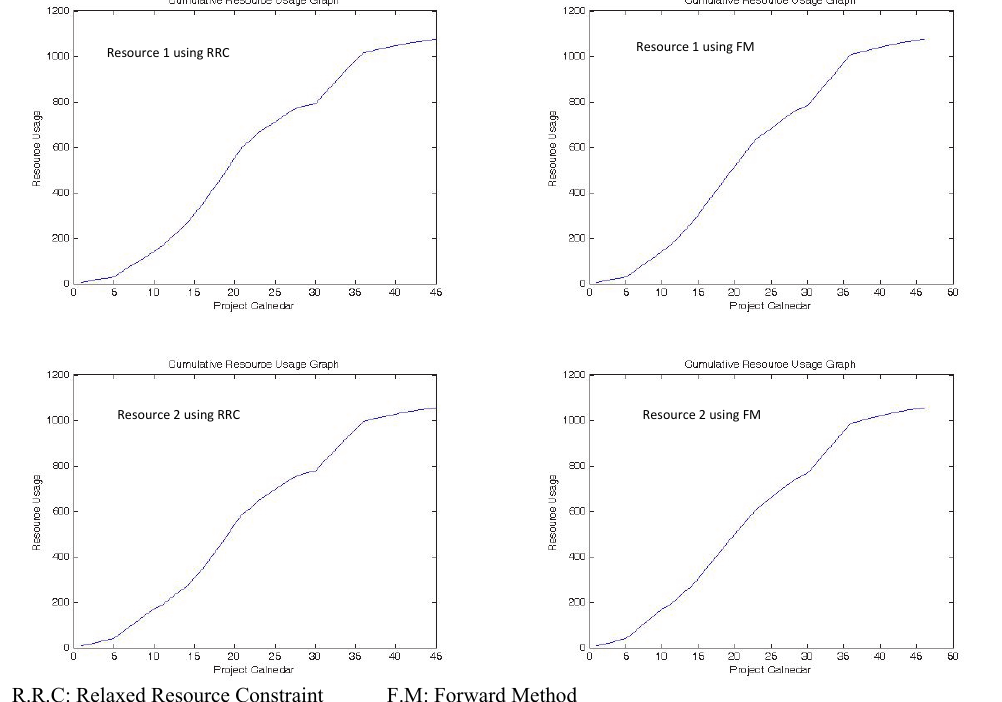
Fig. 7. Comparing the cumulative resource usage while using R.R.C and F.M